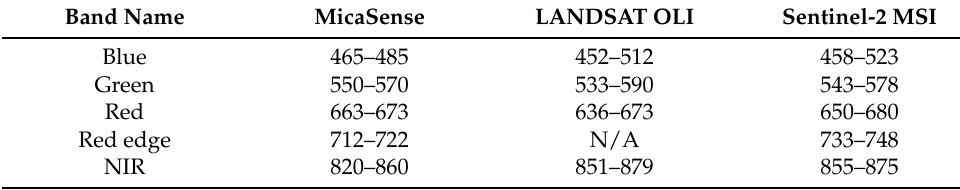
Table A1. MicaSense Red edge camera bands and corresponding satellite instrument bands.